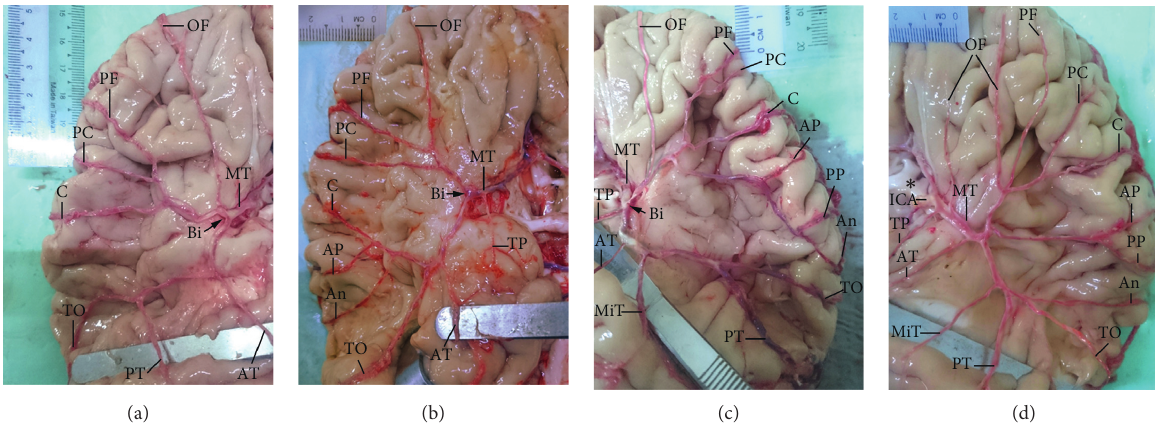
Figure 5: Cortical branches of the MCA. The number of cortical branches varied; 7 (a), 9 (b), 12 (c), and 13 (d) cortical branches are shown as examples. The identified cortical branches were orbitofrontal (OF), prefrontal (PF), precentral (PC), central (C), anterior parietal (AP), posterior parietal (PP), angular (An), temporopolar (TP), anterior temporal (AT), middle temporal (MiT), posterior temporal (PT), and temporo-occipital (TO). The MT and bifurcation (Bi) of the MCA and ICA are indicated. ∗ Optic